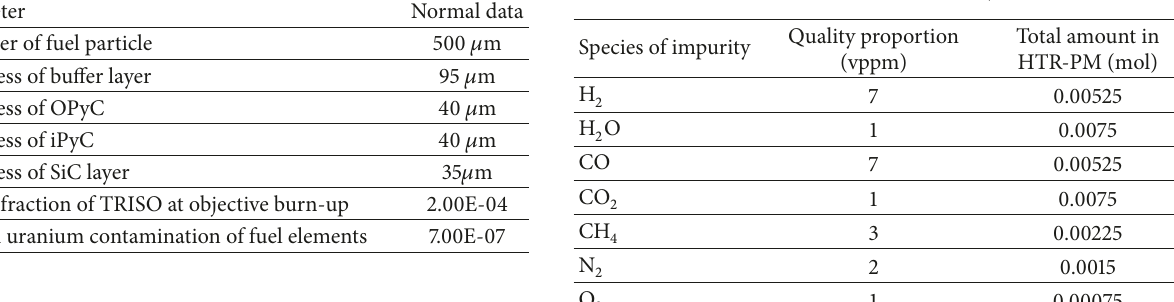
Table 2: Parameters of fuel particles. Table 3: Parameters of gas impurities in Helium (industrial quality follows Chinese National Standard GB/T